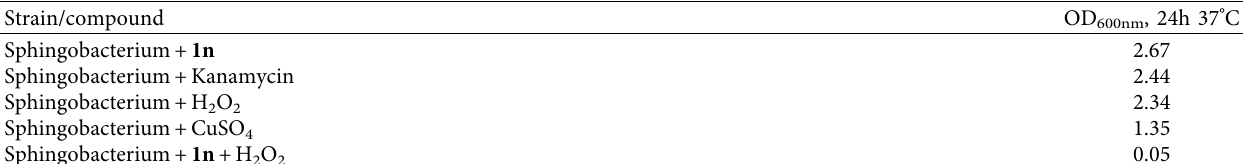
2 O 2 , 1n , and 1n plus H 2 O 2 .